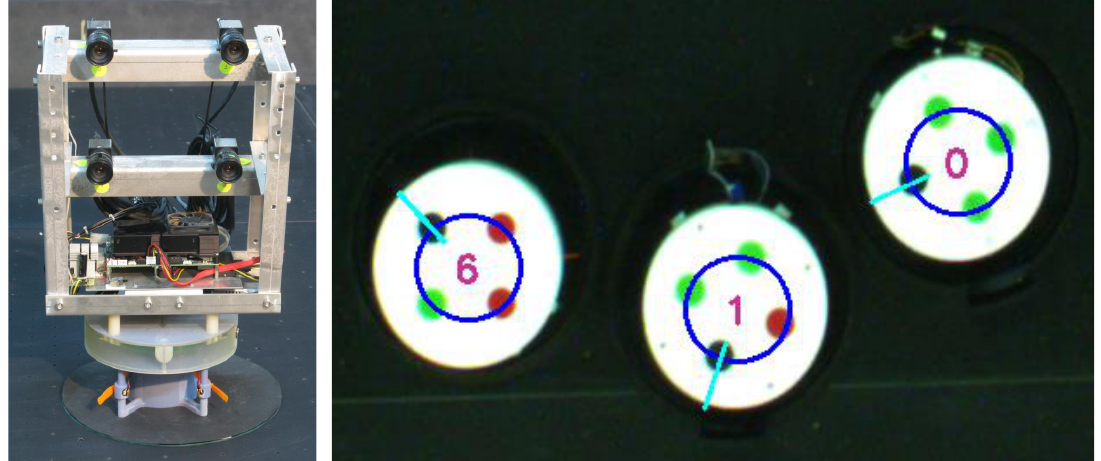
Figure 10. The equipment in the